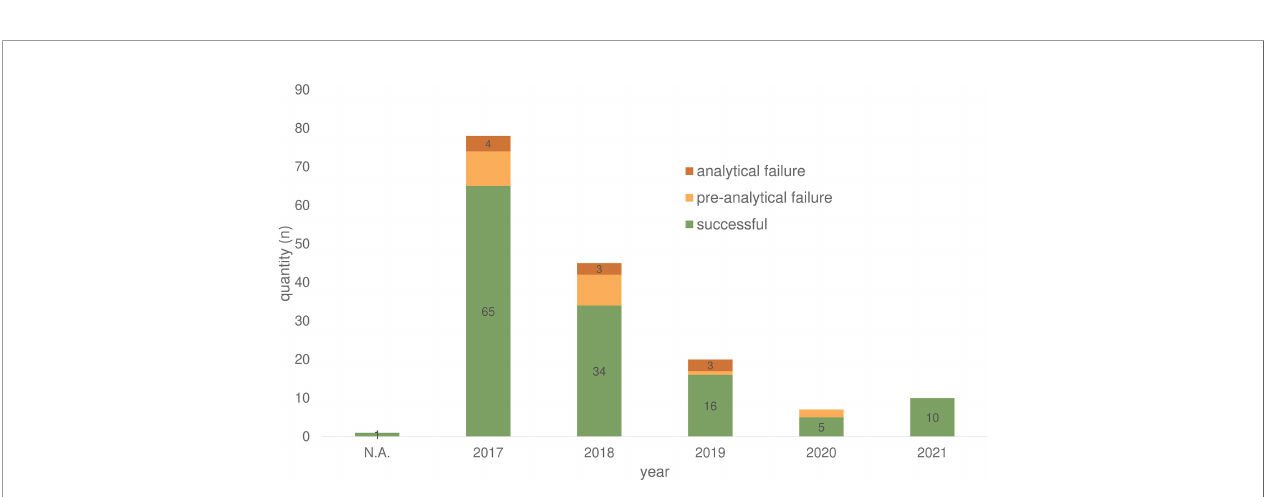
FIGURE 2 | Plasma samples for ctDNA analyses of 86 CRC patients in the period from 2017-2021 divided according to success rate. N.A., not